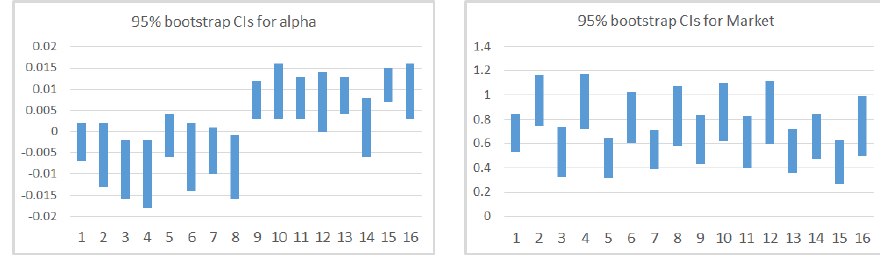
Figure 4. Graphical comparison of 95% Bootstrap CIs for Model